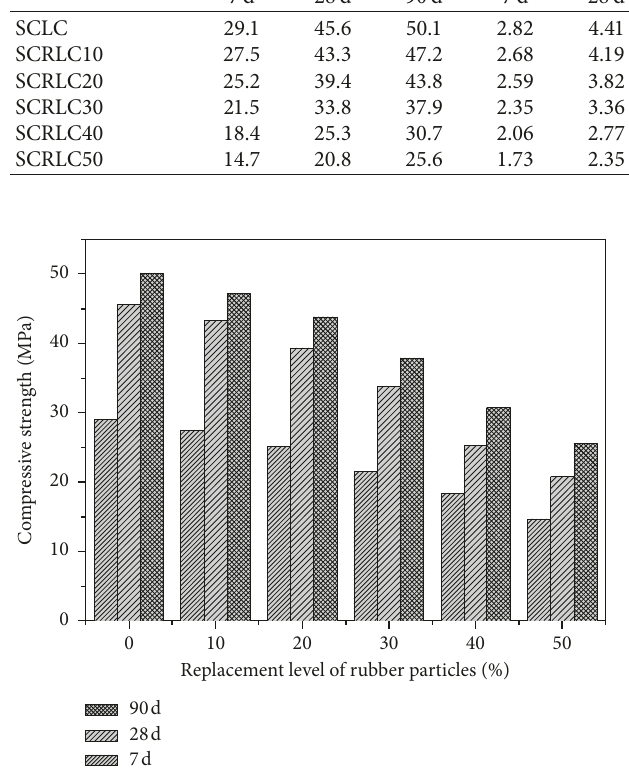
Table 5: The results of compressive strength, splitting tensile strength, flexural strength, and elastic modulus of SCRLC. Type of concrete